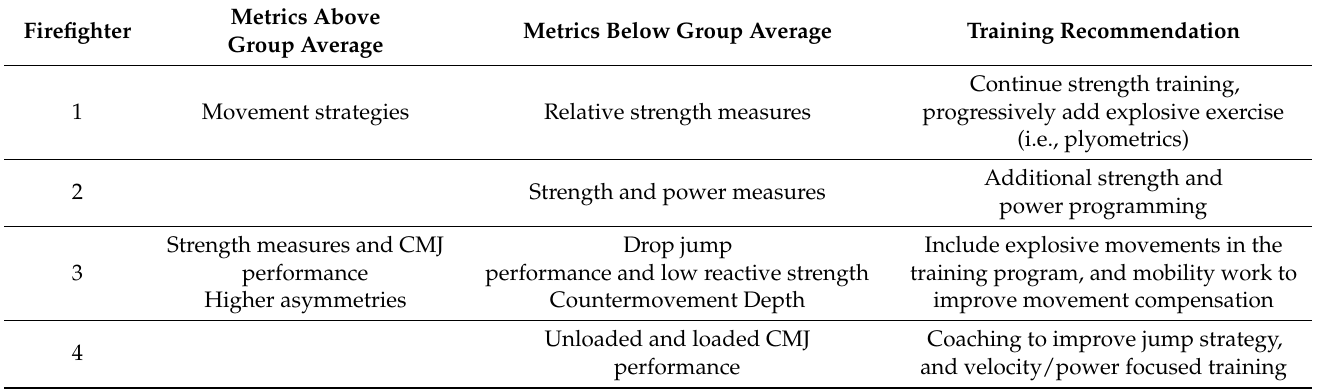
Table 2. Training recommendations based on fitness test performances in Figure